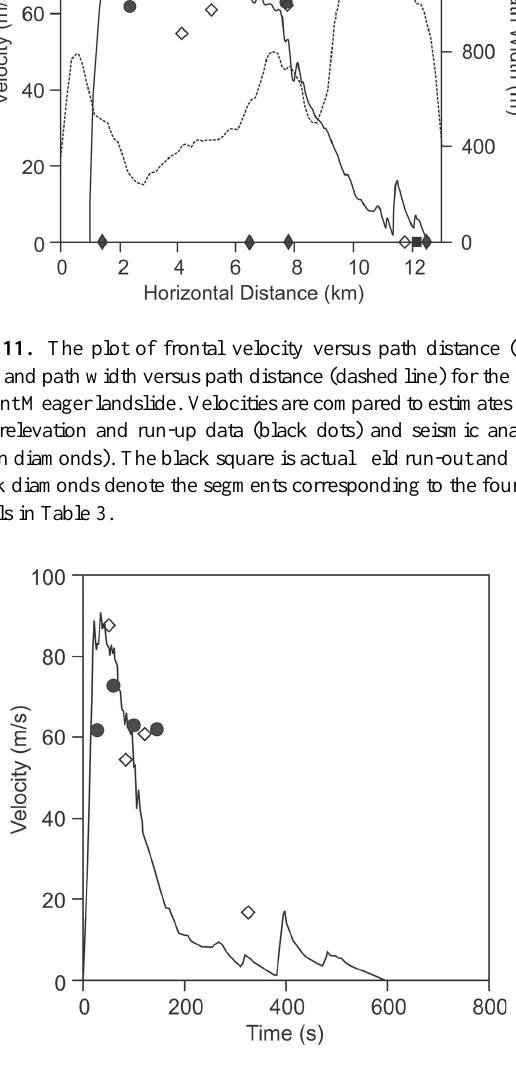
Fig. 12. DAN-W simulation plot of velocity versus time. Velocities are compared to estimates from superelevation in bends and run-up geometry (black dots) and seismic analysis